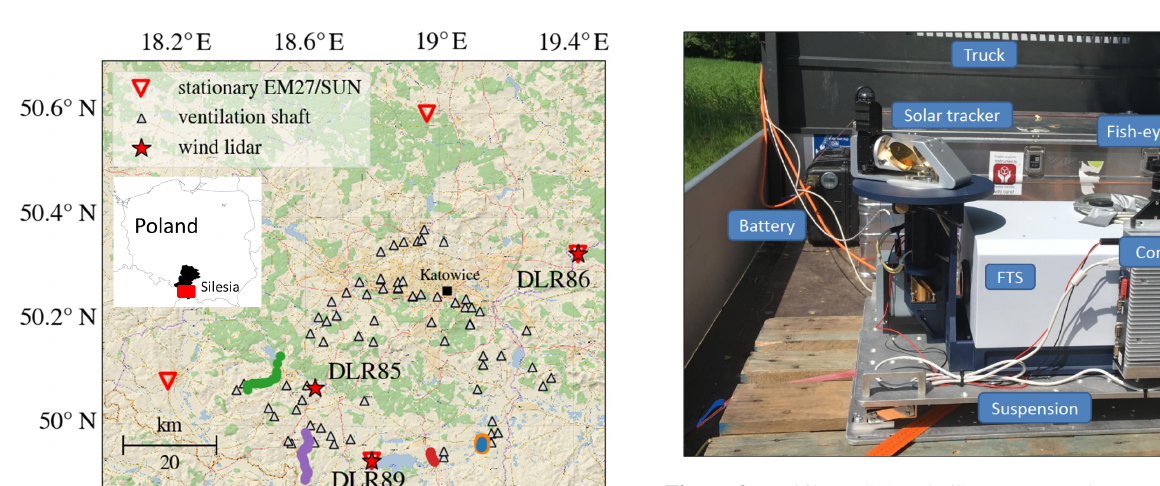
Figure 2. Mobile FTS (EM27/SUN) mounted on a truck. Direct sunlight is collected via the solar tracker. The battery supplies the measurement notebook inside the vehicle, the spectrometer includ- ing the solar tracker, and the control PC. A fish-eye camera auto- matically detects the solar disc in the sky above the spectrometer. The control PC steers the solar tracker towards the solar